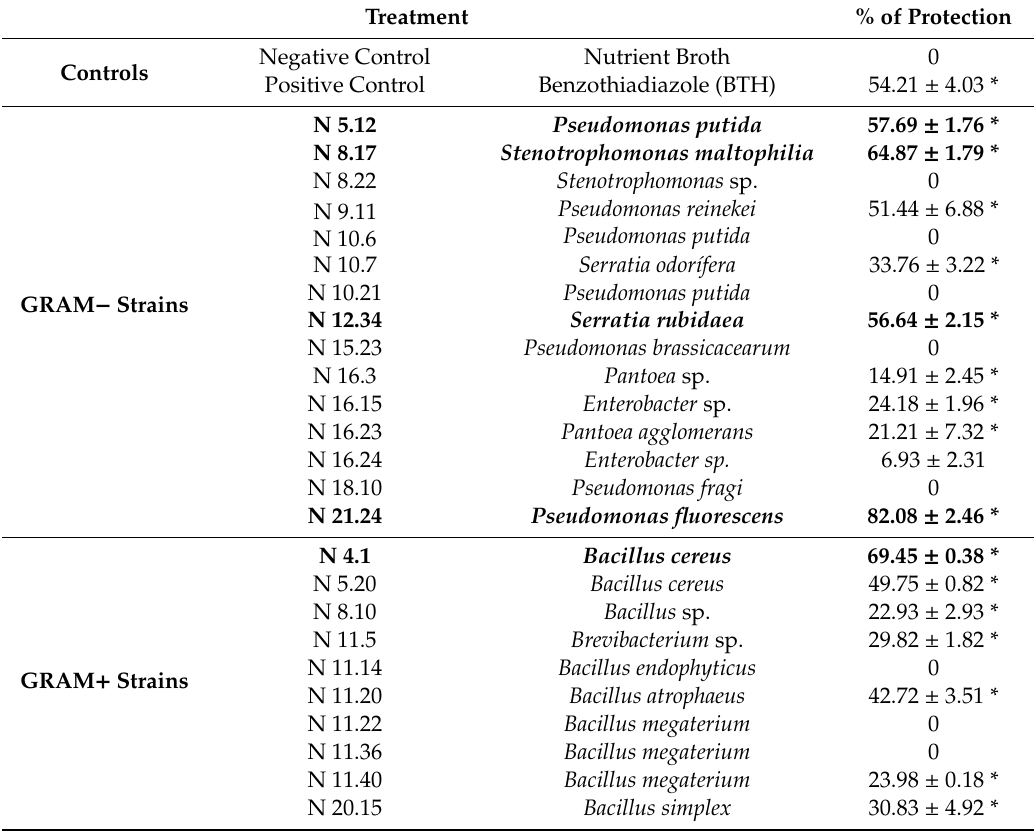
Table 3. Percentage of protection (%) induced in A. thaliana seedlings inoculated with chosen strains against